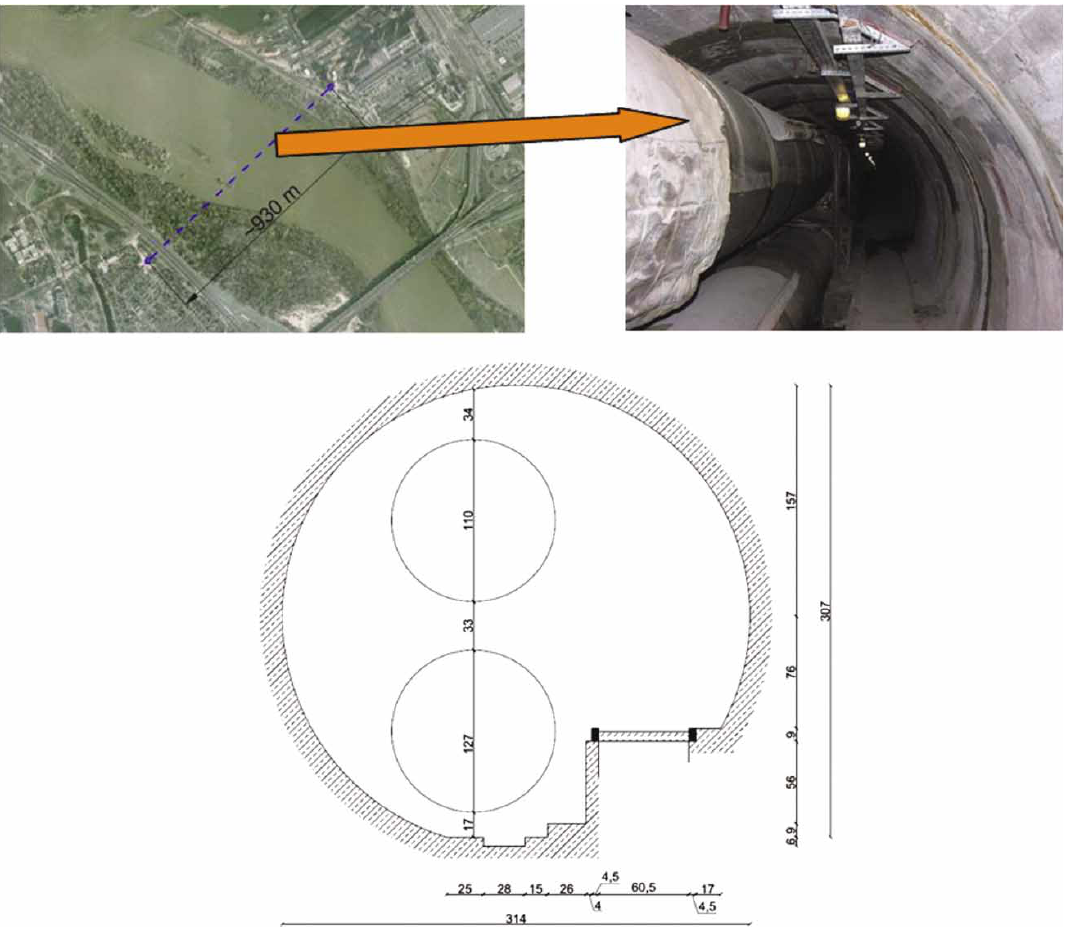
Fig. 6. Location, general view and cross section of tested tunnel under river (Gorzelan´czyk et al .